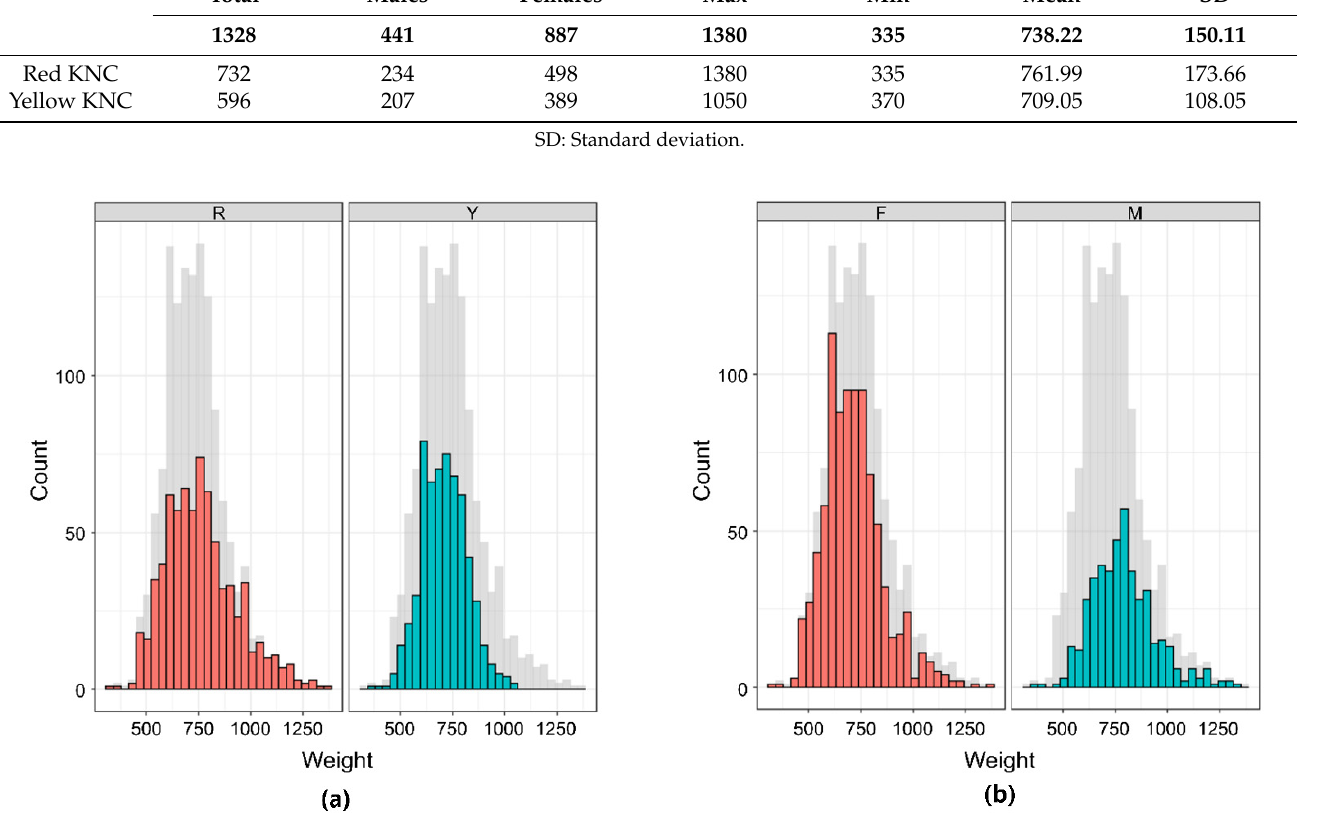
Figure 1. Phenotypic distribution of the body weight records measured at age 8 weeks. ( a ) Distribution for each breed (R: Red Korean native chicken (KNC); Y: Yellow KNC); ( b ) Distribution for each sex (F: female; M: male) The shadow in the background represents the total population. Table 2. Results of variance component estimation for body